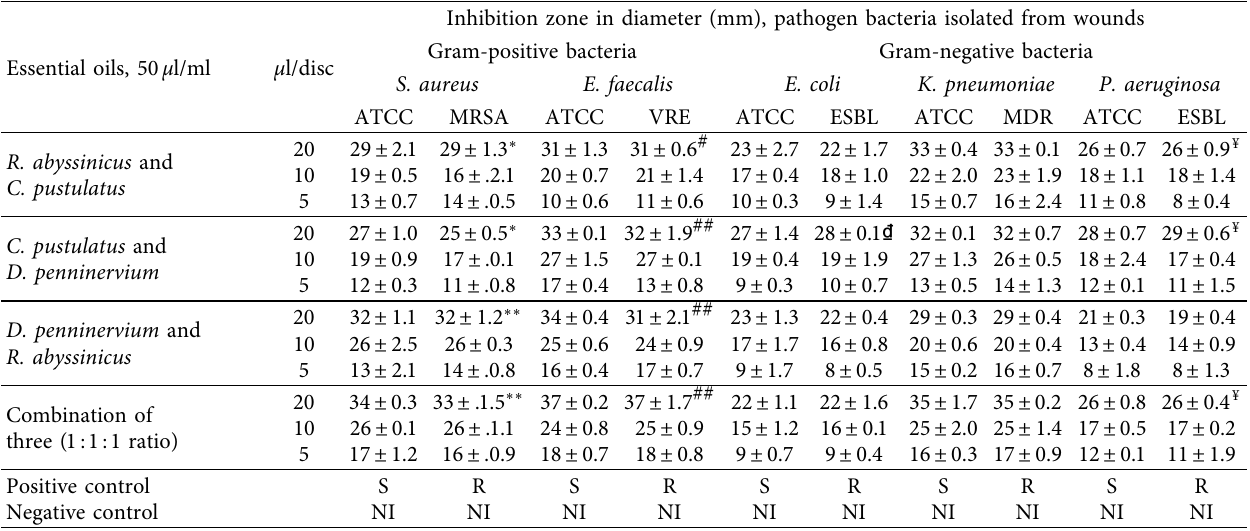
Table 3: Inhibition zone (mm) of combined essential oils against MDR bacteria isolated from wounds at KMU, 2020. Essential oils, 50 μ l/ml